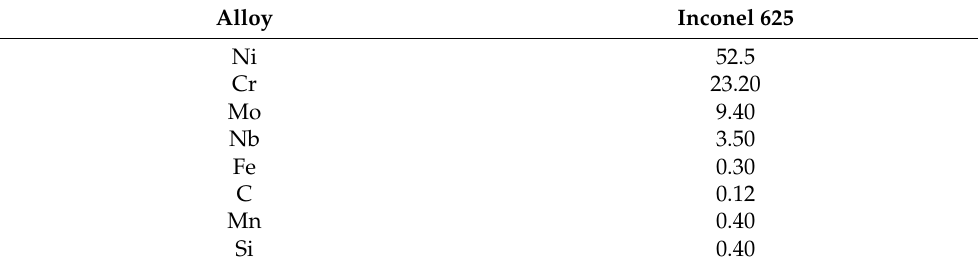
Table 3. The chemical composition of Inconel 625 alloy [68], [wt. %]. Alloy Inconel 625 Ni 52.5